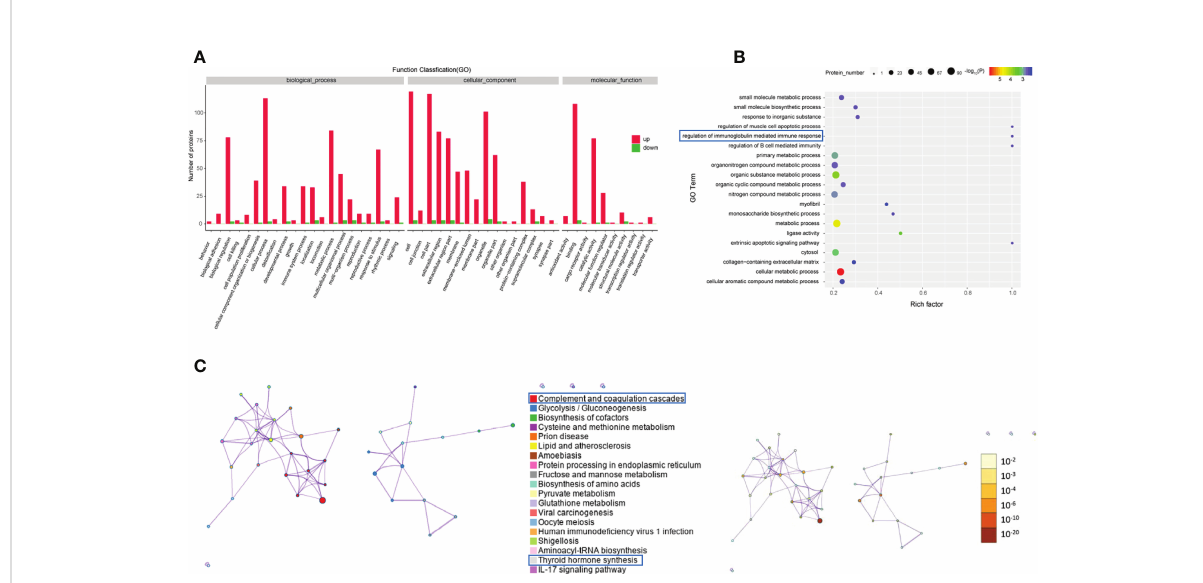
FIGURE 3 Gene Ontology and KEGG analyses of differentially expressed proteins from the GO group and the GD group. (A-C) Gene Ontology annotation (A) , Gene Ontology enrichment (B) , and KEGG enrichment (C) analyses of differentially expressed proteins in exosomes from the GO group and the GD group.